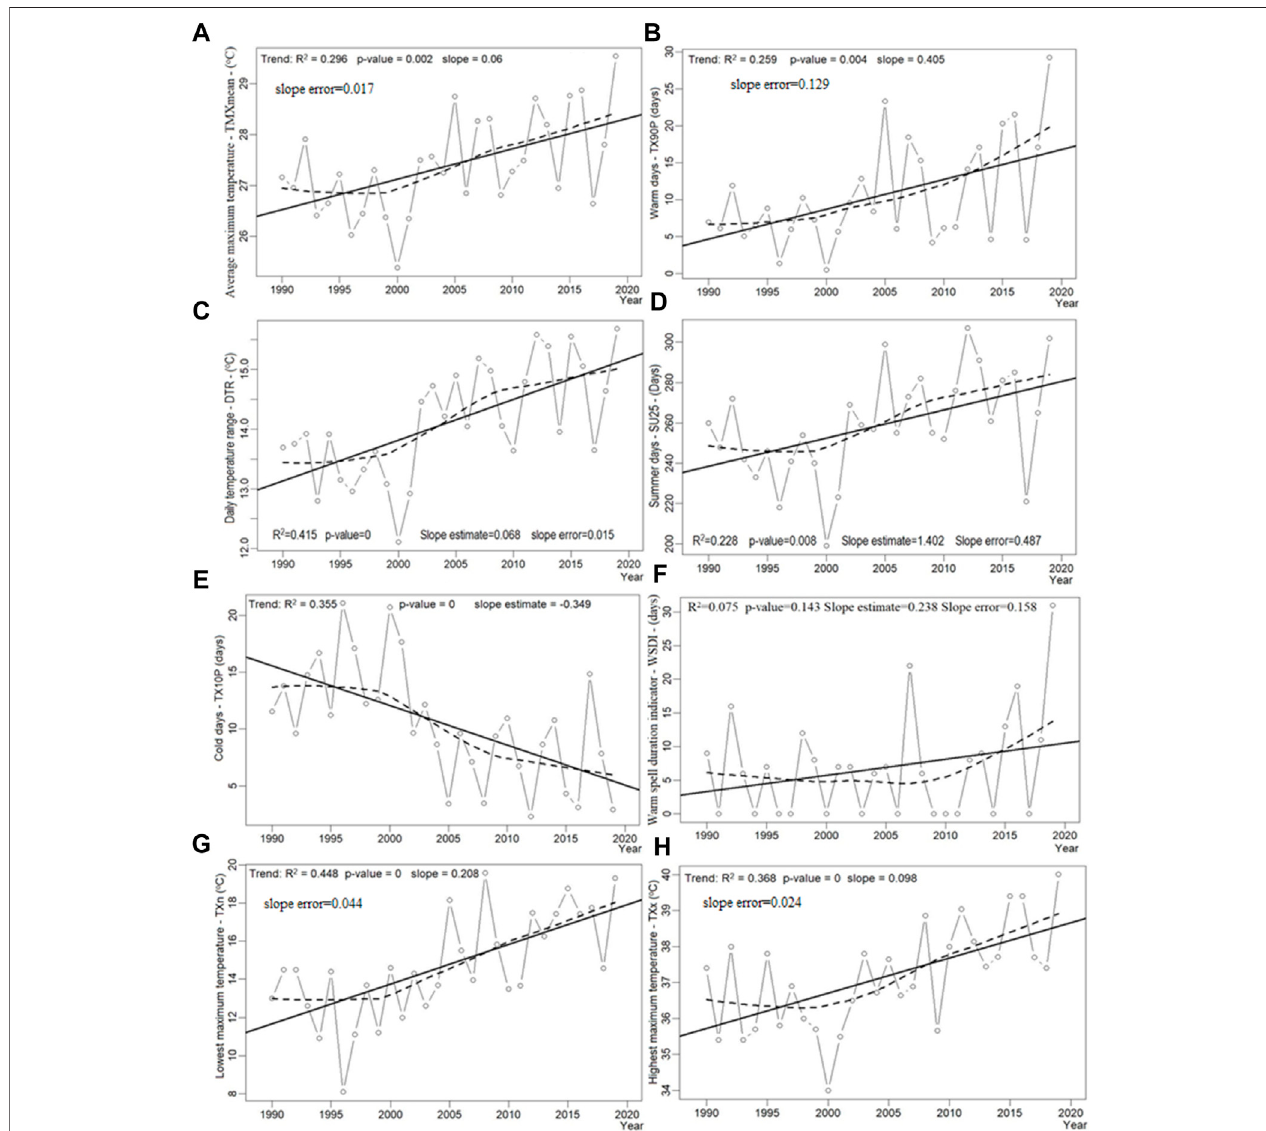
FIGURE 4 | Trends in (A) Mean maximum temperature, (B) Warm days, (C) Daily temperature range, (D) Summer days, (E) Cool days, (F) Warm spell duration indicator, (G) Lowest maximum temperature, and (H) Highest maximum temperature at the Goertz Observatory in